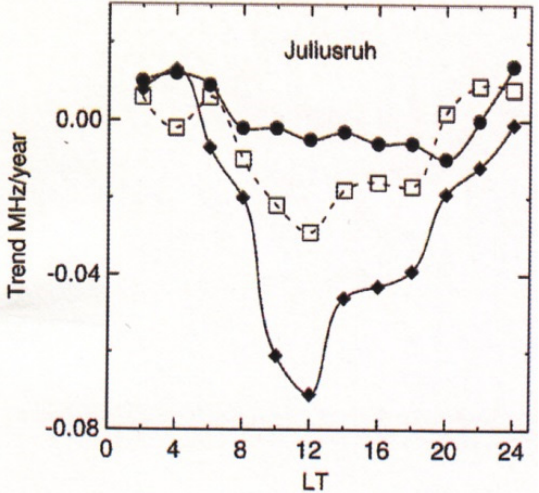
Figure 1. Dependence of trends in foF2 on local time and season for Juliusruh, northernmost Germany. Circles—June; rectangles—September; diamonds—February. From [11].